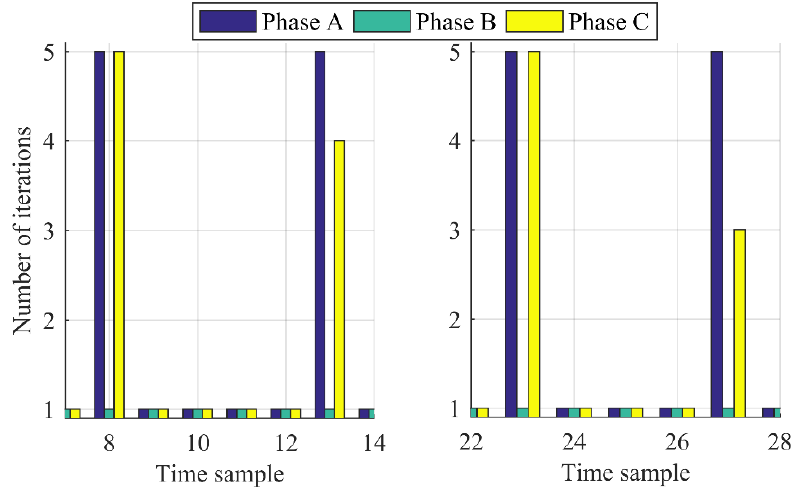
Figure 14. Number of algorithm iterations—case 4.